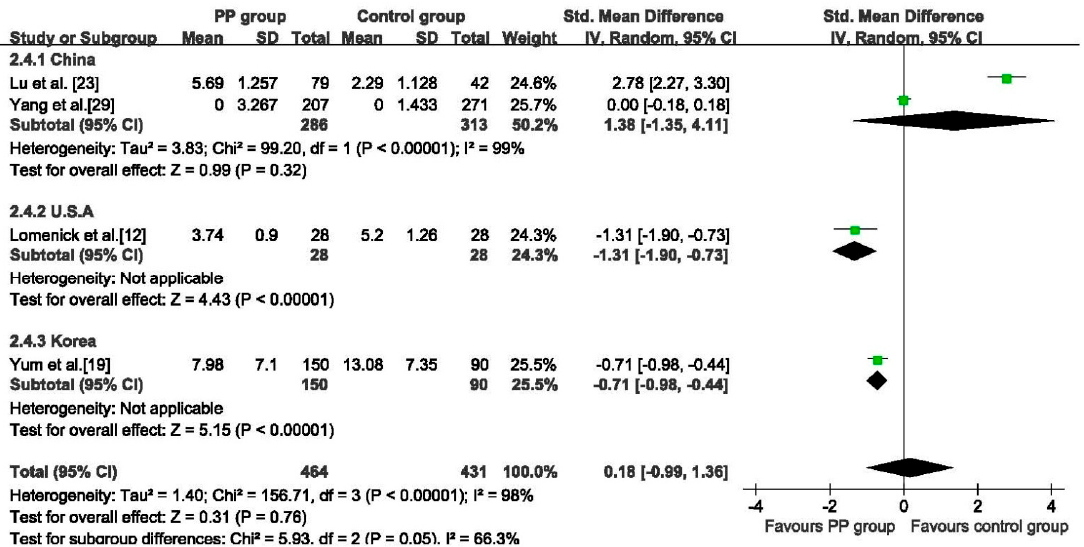
Figure 6. Forest plot for concentration of MEHP between PP group and Control group.